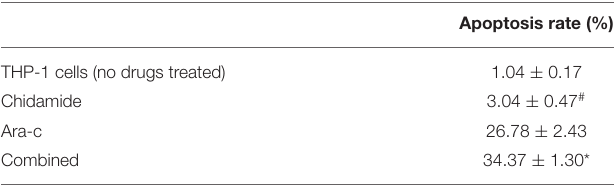
TABLE 3 | The change in the apoptosis of THP-1 cell lines treated by chidamide, Ara-c, and Ara-c combined with chidamide.